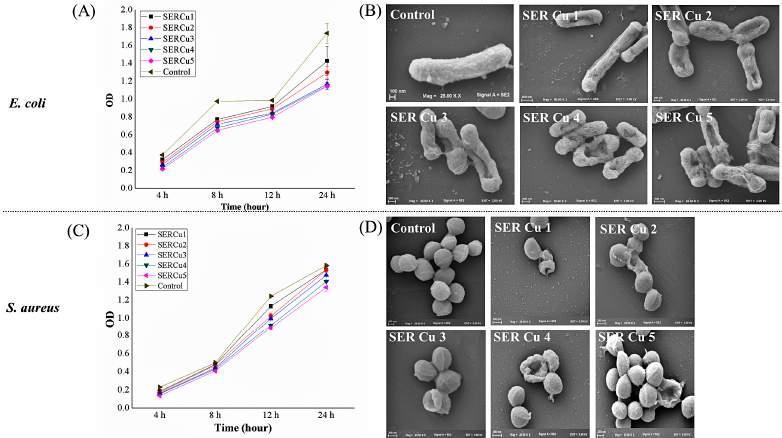
Figure 7. ( A ) Growth kinetics of E. coli treated with 500 µ g/mL of Cu-SER MOFs for 24 h. ( B ) Scanning electron micrographs of E. coli post-treatment. Scale bar = 100 nm (Control), 200 nm (SER Cu 2 and SER Cu 4), and 300 nm (SER Cu 1 and SER Cu 5). ( C ) Growth kinetics of S. aureus treated with 500 µ g/mL of Cu-SER MOFs for 24 h. ( D ) Visualization of bacterial cell surface by SEM. Scale bar = 100 nm (Control), 200 nm (SER Cu 2 and SER Cu 4), and 300 nm (SER Cu 1 and SER Cu